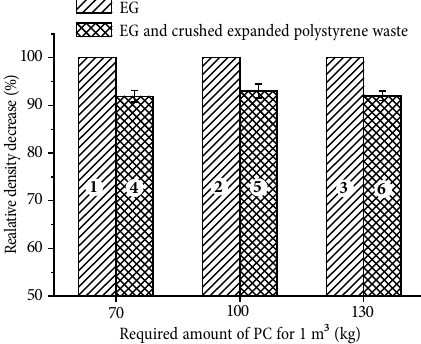
Fig. 3. Influence of the amount of PC on relative density decrease of LWAC samples of 1÷6 compositions